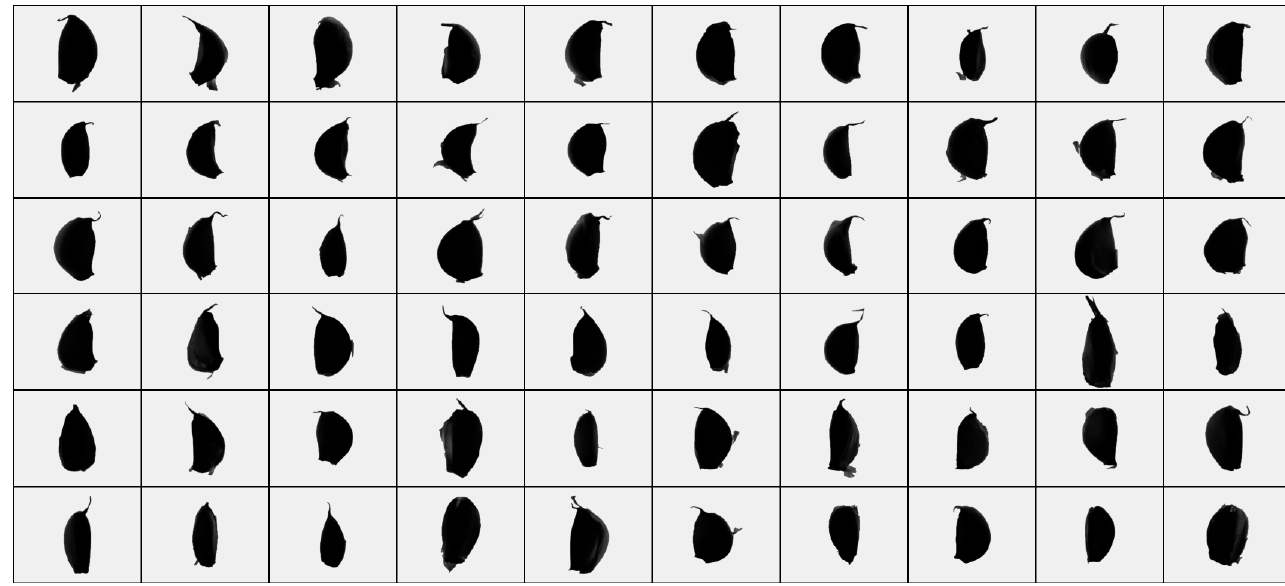
Figure 4. Part of the original